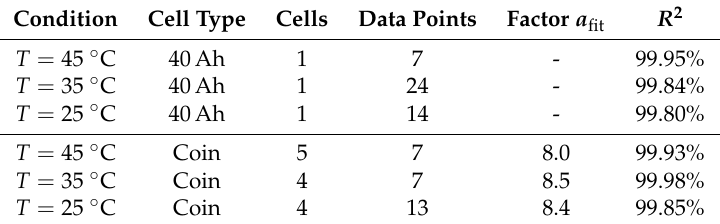
Table 6. Slope factor a fit = A coin / A 40 Ah from the fit functions. The boundary conditions are X fit > 0 fit fit and A fit > 0. Furthermore, the goodness of fit R 2 is listed based on the number of data points taken into account.